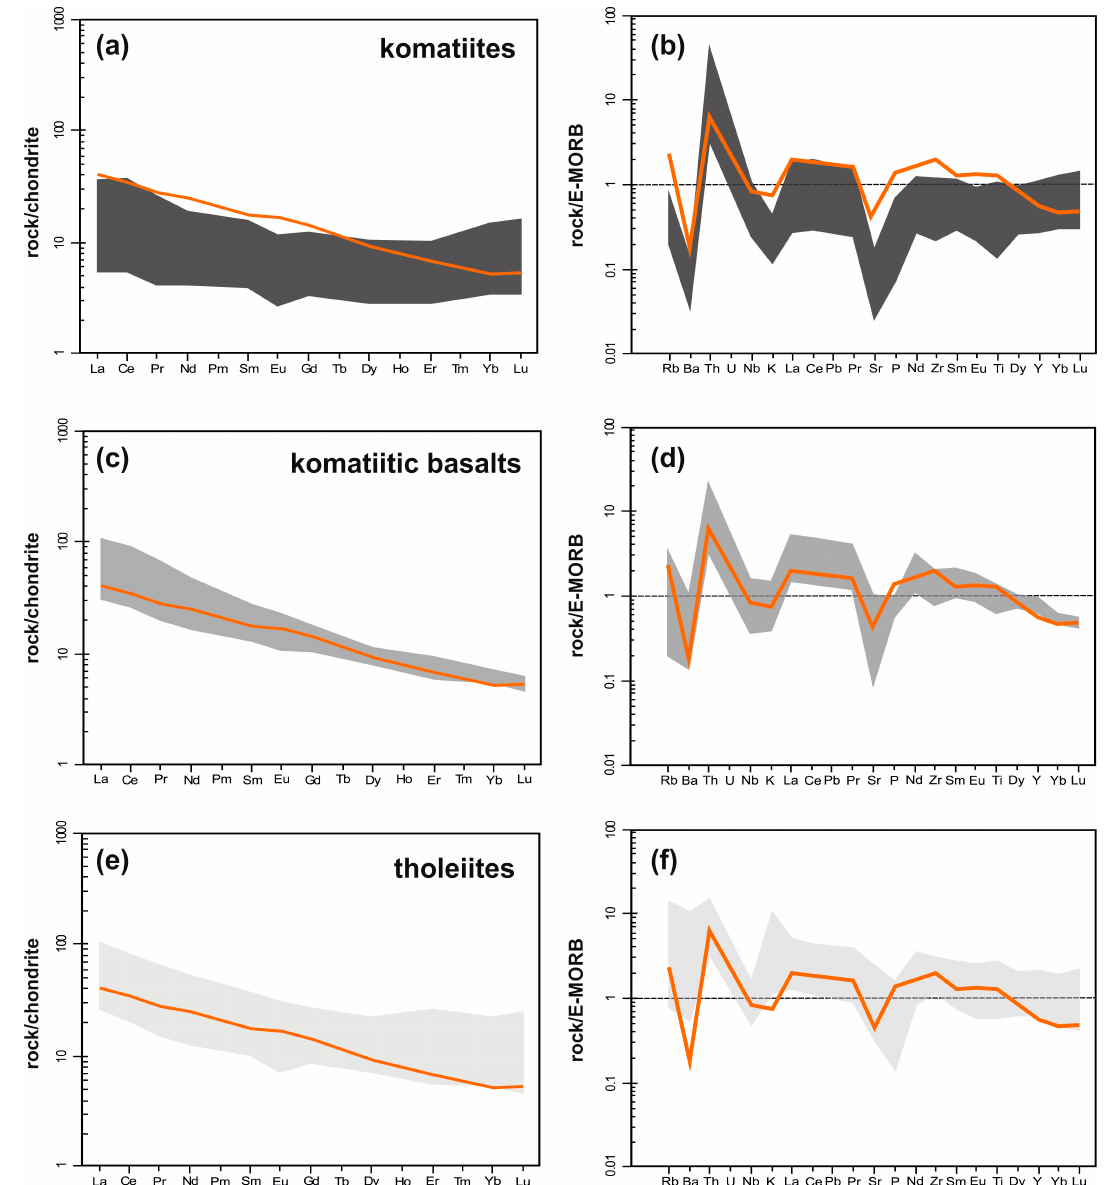
Figure 11. ( a , c , e ) chondrite-normalized REE patterns for komatiite, komatiitic basalts and tholeiite respectively (normalizing values after [43]), ( b , d , f ) E-MORB normalized multielement spider diagrams (normalizing values after [44]) for the komatiite, komatiitic basalts and tholeiite respectively (data from [10]), REE and multi-element patterns of AR-6C (brown line) shown for comparison.